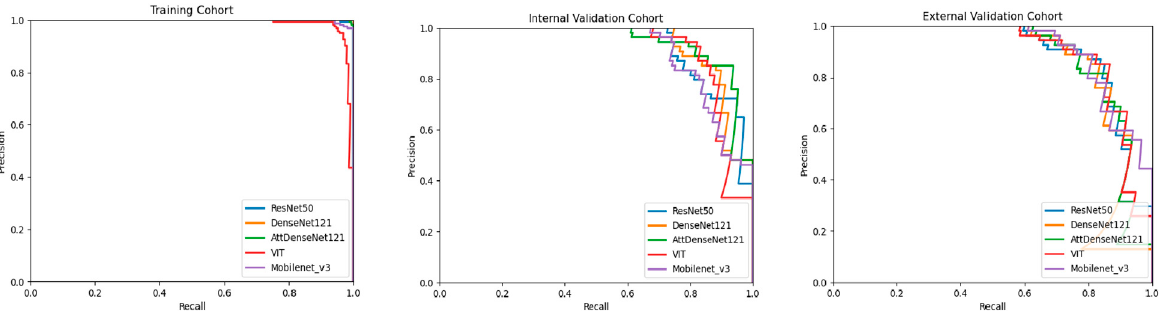
Figure 4. Comparison of P-R curves among DL models for predicting TIL levels in the training co- hort, internal validation cohort, and external validation cohort. AttDenseNet121 attention-based DenseNet121, VIT Vision Transformer. Table 2. Performance of five DL Models according to validation cohorts.